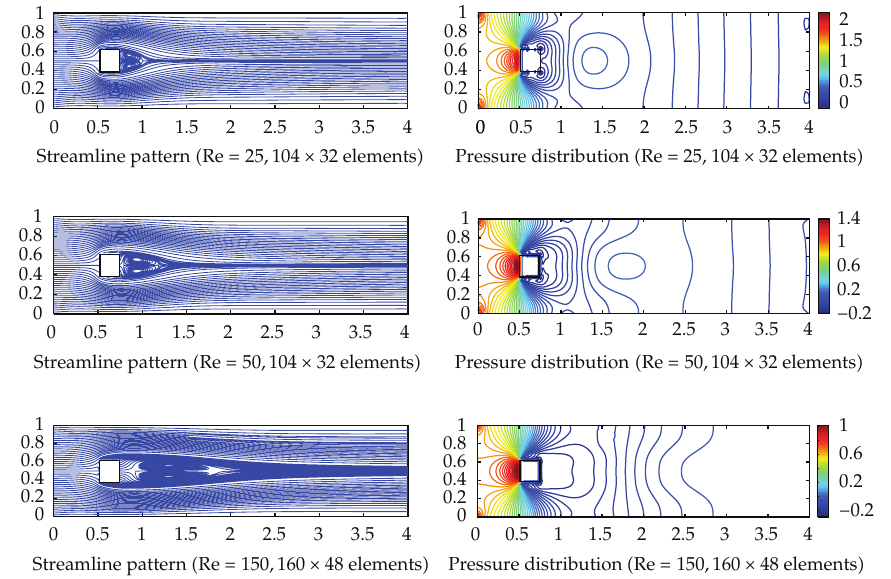
Figure 4: Streamline pattern and pressure distribution for flow field at di ff erent Re